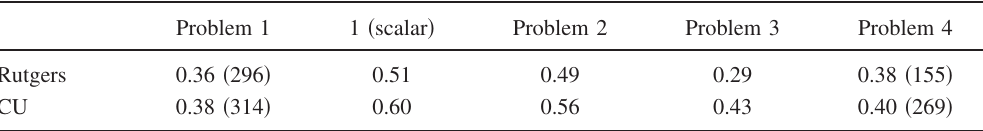
TABLE I. Fraction of students answering the four recitation problems correctly at Rutgers and CU. Parentheses indicate sample sizes. Samples for problems 1, 2, and 3 are the same. Standard errors vary but are on the order of 0.03. The 1 (cid:1) scalar (cid:2) category refers to the scalar portion of the answer for problem 1.